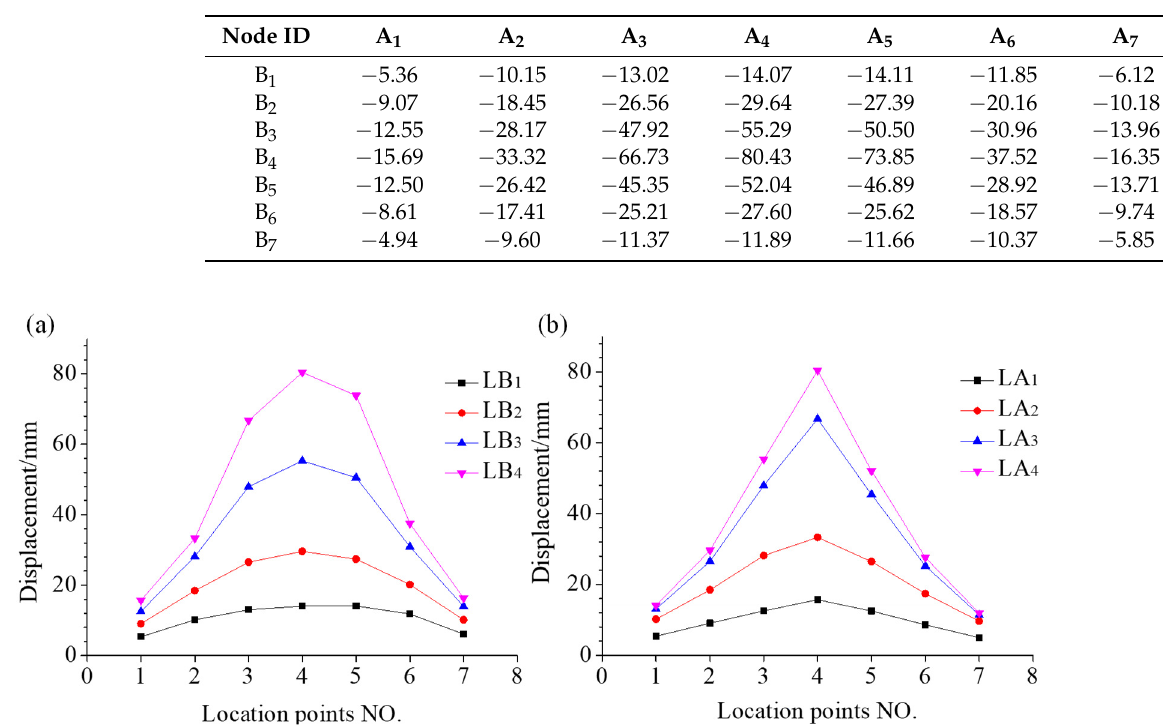
Table 4. Measured deformation of the stiffened panel.